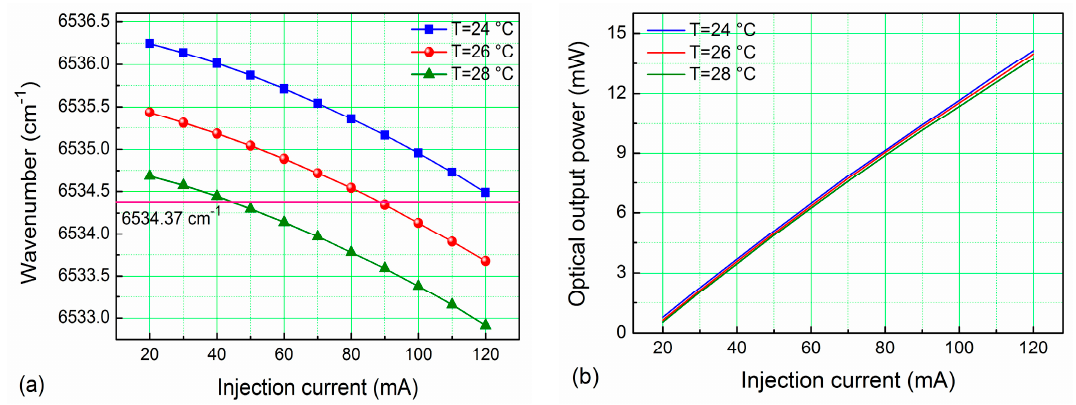
Figure 4. The 1.53 μ m CW DFB diode laser output performance: ( a ) wavelength at different TEC temperatures and injection currents; ( b ) optical output power at different TEC temperatures and injection currents.